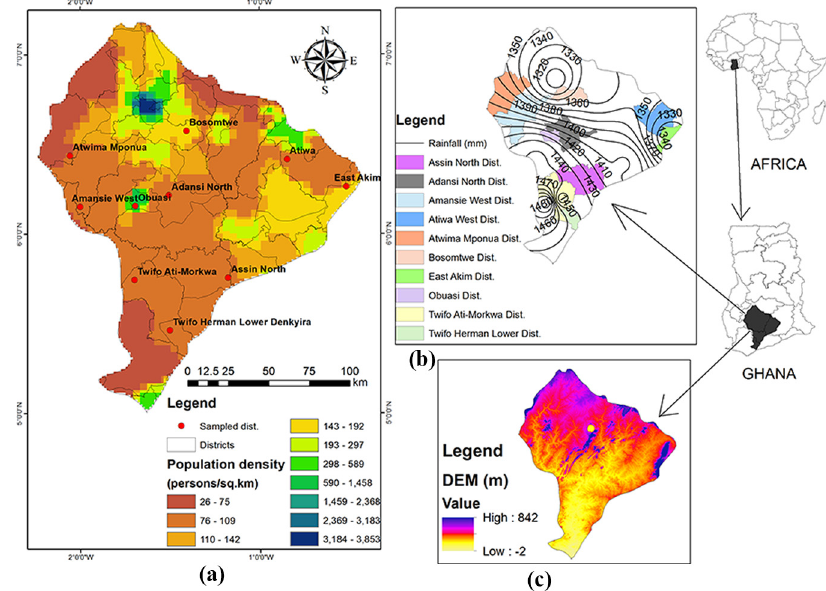
Figure 1. Map of Pra